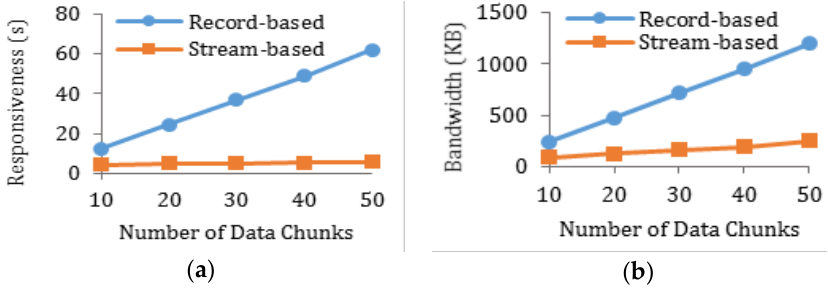
Figure 8. Communication overhead in sharing data stream through record-based and stream-based digest generation, measured in ( a ) responsiveness and ( b ) bandwidth.